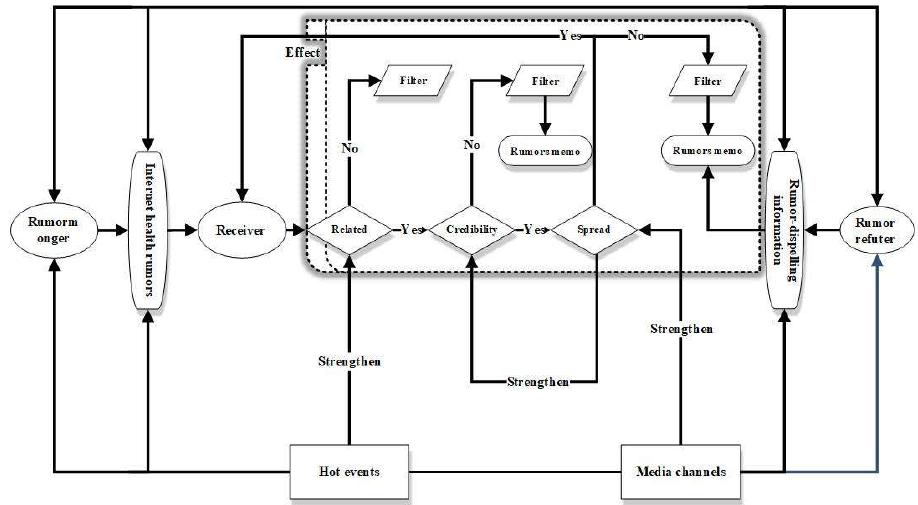
Figure 4. Relationship among eight-element communication model. Rumor memo: meaning the receiver knows that this health information is a rumor, marks it as “rumor”, and would not believe and spread it.